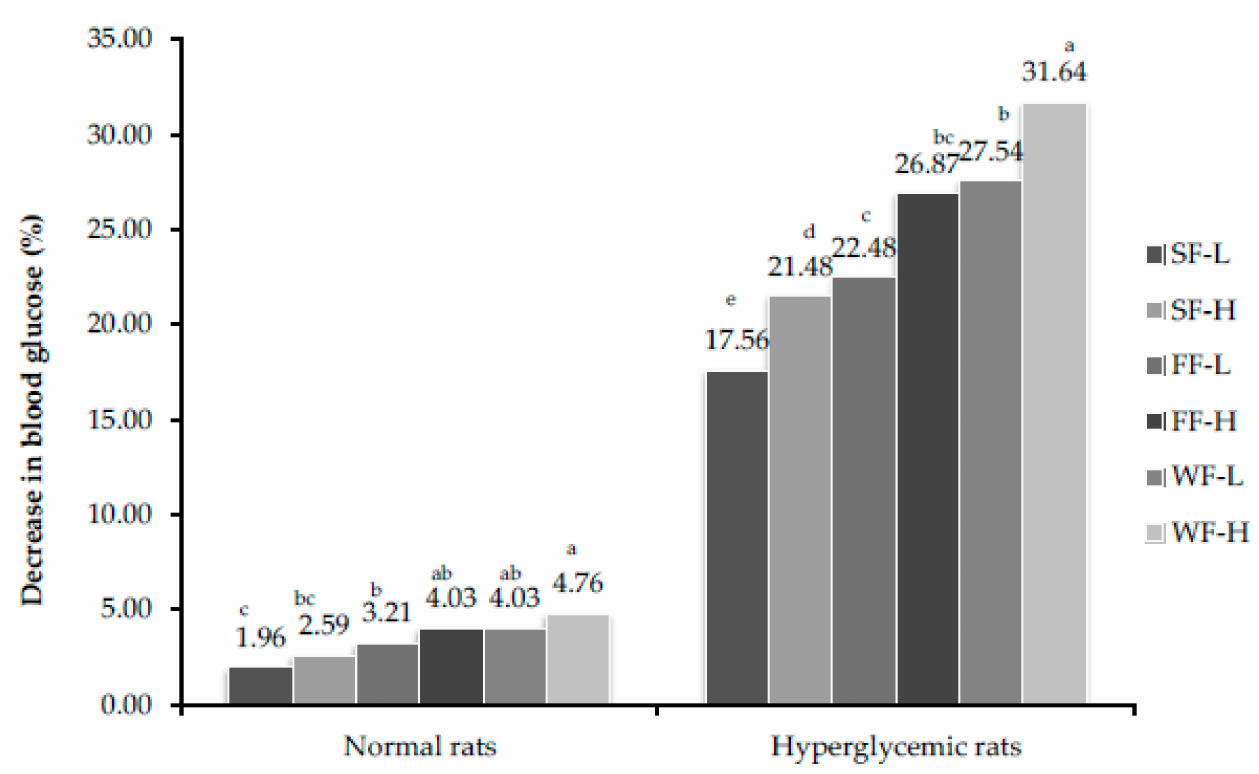
Figure 3. Percent decrease in glucose level after feeding bitter gourd on 56th day. Bars that do not share similar letters denote statistical significance ( p <